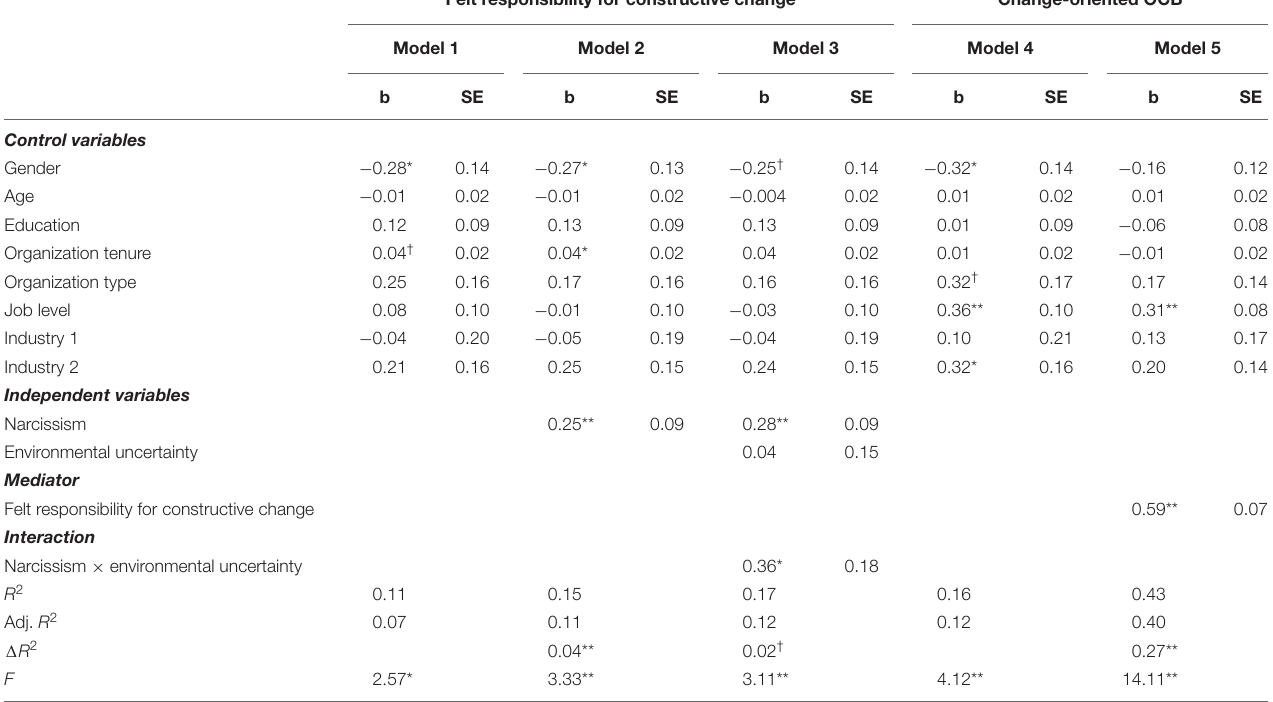
TABLE 3 | Study 1 regression results.